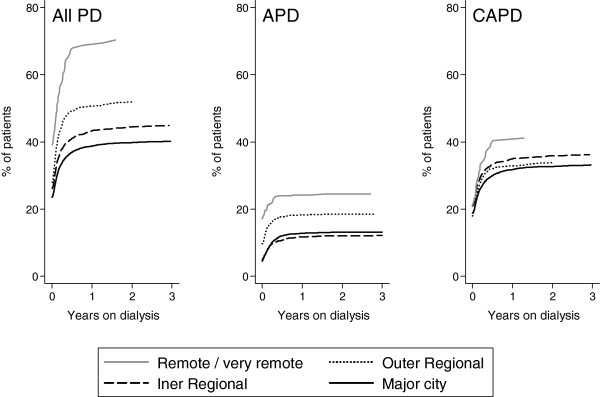
Uptake of all PD, CAPD and APD over time, by remoteness categories.